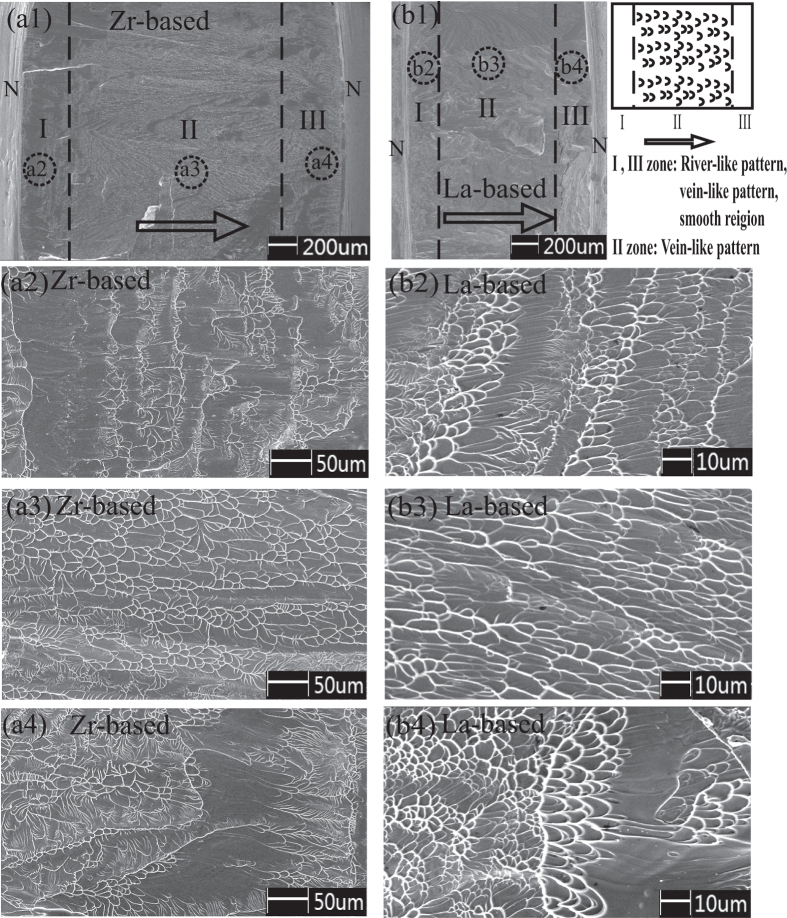
SEM images for pure shear fracture surface morphology of Zr52.5Cu17.9Ni14.6Al10Ti5 and La60Ni15Al25.(a) Zr52.5Cu17.9Ni14.6Al10Ti5. (b) La60Ni15Al25. (a1), (b1) are whole fracture morphology. Three characteristic zones are marked with I, II and III, and the schematic diagram is shown in the right part. Zone I and III stand for the parts near the notch edges and present mixed features; zone II presents the vein-like pattern. Arrows stand for the direction of shear Vein-like patterns. N represents the notch position. (a2), (a3), (a4) and (b2), (b3), (b4) are the detailed fracture morphology in zone I, II and III, respectively, which circled by the black dashed circles in Fig. 4 (a1) and (b1).